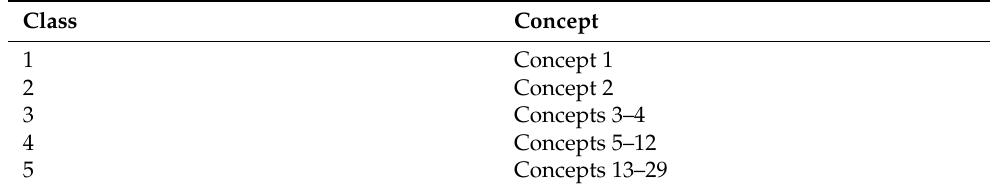
Table 7. Class memberships of extracted concepts by singular value decomposition via